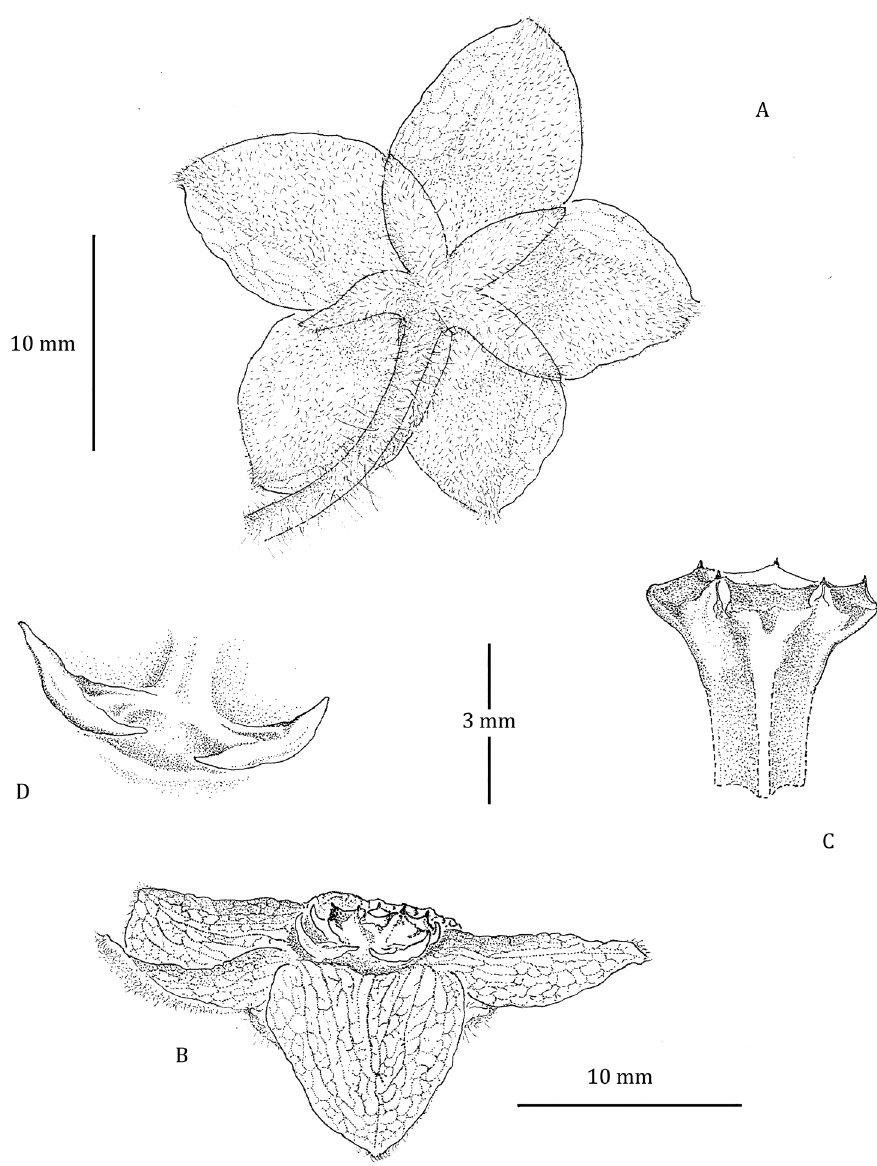
Figure 3. Flower of Phaeostemma surinamensis . A Abaxial view showing calyx and abaxial corolla lobes B Side view showing adaxial corolla surface and gynostegial corona C Style-head D Staminal corona (Cs). Based on Lindeman et al. 654